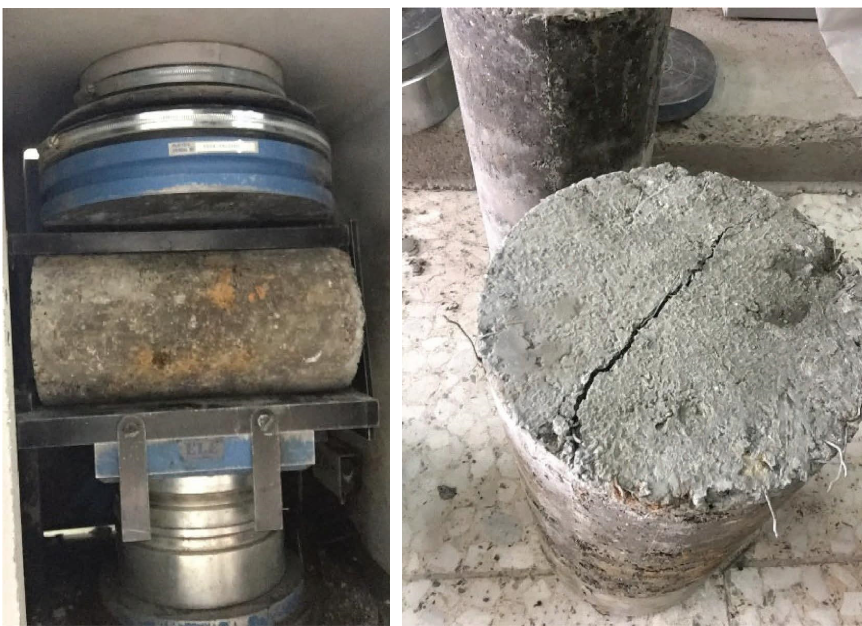
Figure 5: Tensile strength